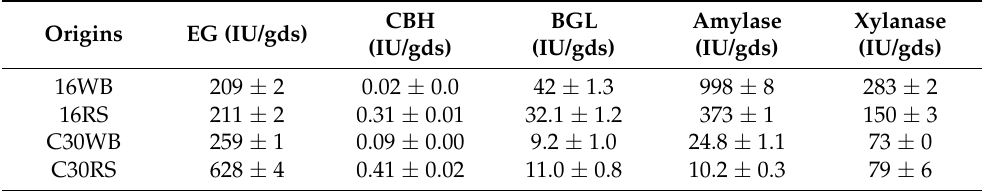
Table 1. Comparation of the main GH